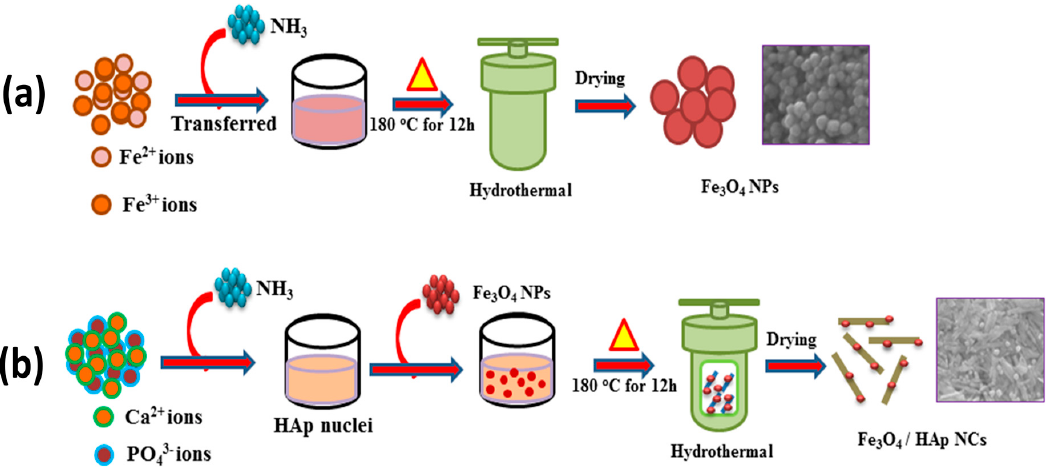
Figure 6. ( a ) Schematic illustrations for the synthesis of Fe 3 O 4 NPs and ( b ) Fe 3 O 4 /HAp nanocomposites (NCs) synthesis through a hydrothermal process at 180 °C for 12 h.